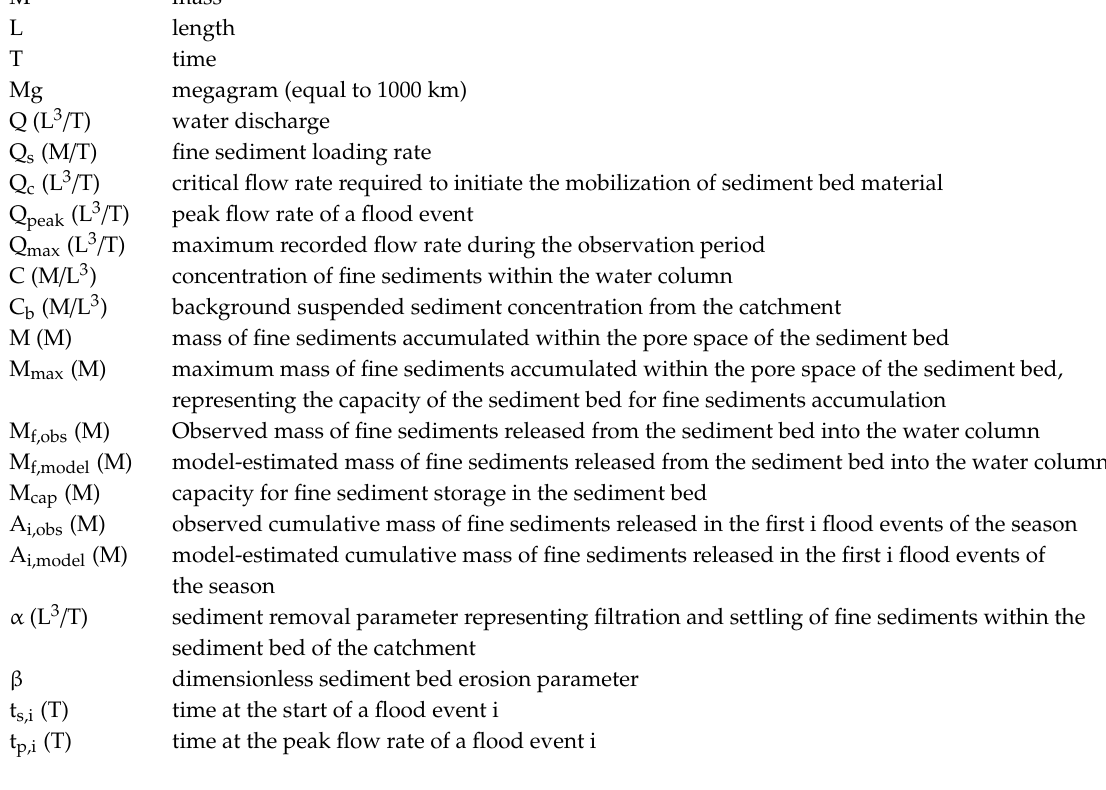
Figure S1: Q vs Q s , Figure S2: Background line, Figure S3: Hysteresis analysis, Figure S4: Sensitivity analysis, Figure S5: Model calibration, Table S1: Study